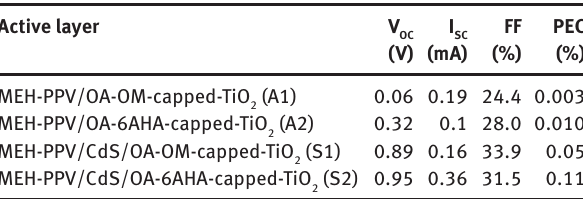
Table 1 Summary of the photovoltaic parameters of BHJSC devices with active layer blends A1, A2, S1, and